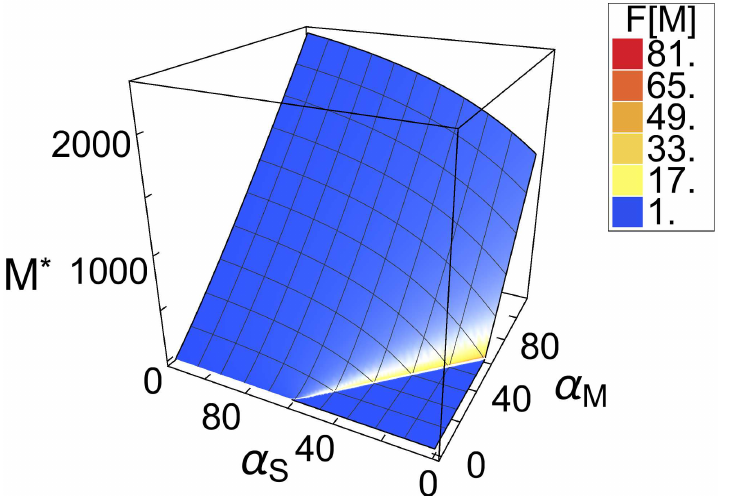
Fig 4. Fluctuations in long mRNA abundance. The fluctuations are quantifiedby the Fano factor (see main text) and depicted as heatmapin the plot. They are most pronouncedat the threshold, and fade for parameter sets abovethe threshold. With an increasein sRNA production( N α S ), the fluctuations become smaller and more localizedto the threshold. This illustrateshow the third componentsRNA acts as a means to reduce intrinsicfluctuations. The production rate of CsrA dimers was again set to α A = 58.52, and all other system parameters are given in S1